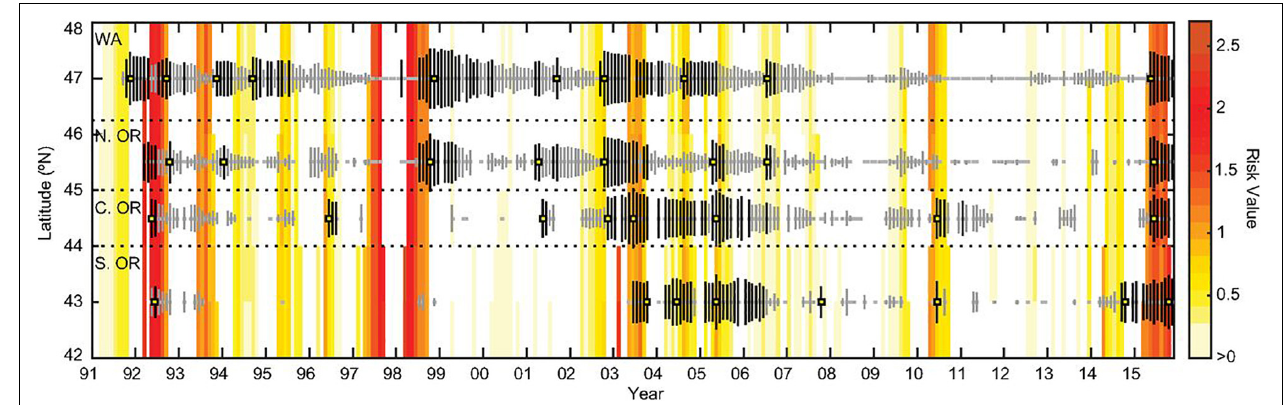
FIGURE 4 | Domoic Acid (DA) risk analysis model output (yellow to red) and DA levels in Oregon (OR) and Washington (WA) razor clams (vertical bars) from 1992 to 2015. Model values indicate increased risk of elevated DA based on proxies of warm ocean parameters; model values are only calculated during upwelling season, when concentrations of phytoplankton are likely to be greatest each year. White regions indicate that elevated DA is least likely, as the model equals zero and/or it is downwelling season. From top to bottom, monthly maximum DA values (vertical bars) are latitudinally binned as follows: WA (46.3 ◦ N to 48 ◦ N), northern OR (45 ◦ N to 46.3 ◦ N), central OR (44 ◦ N to 45 ◦ N), and southern OR (42 ◦ N to 44 ◦ N). Bar length is proportional to the monthly maximum DA value. Color indicates DA ≥ 20 ppm (black lines), from 1 to < 20 ppm (gray lines), or not detected (gray squares). An absence of points indicates no DA data available. Annual DA maxima used in model evaluation are highlighted with yellow squares. Figure from McKibben et al.